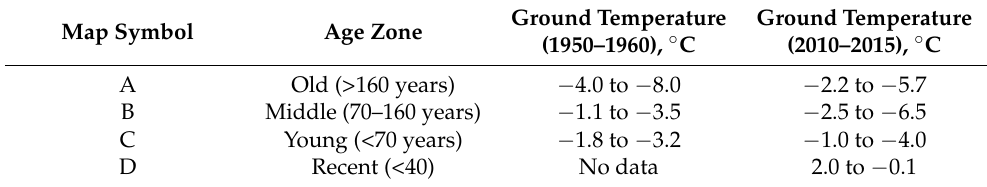
Table 9. Ground temperatures and magnitude of their change in different age zones, Yakutsk. Map